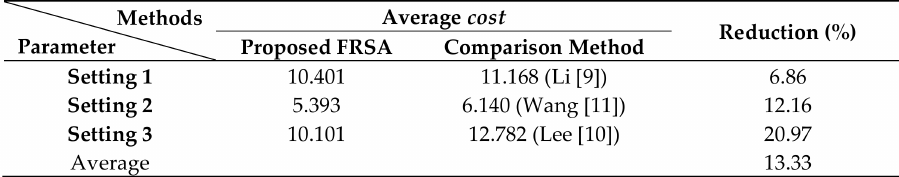
Table 7. Comparison of average cost with related studies.